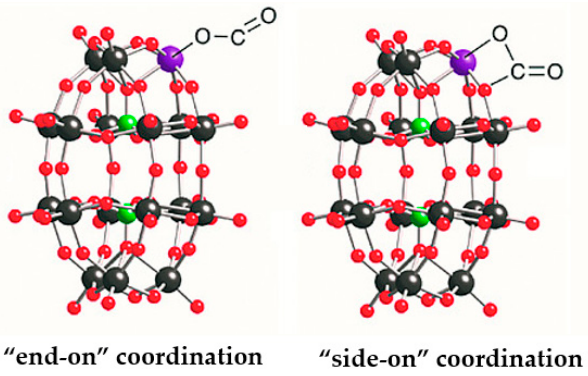
Figure 2. Suggested modes of coordination of CO 2 . Color code: W, black ball; P, green ball; O, red ball; Zn, purple ball. Reprinted with permission from [21]. Copyright © 2018 Wiley-VCH Verlag GmbH and Co. KGaA.